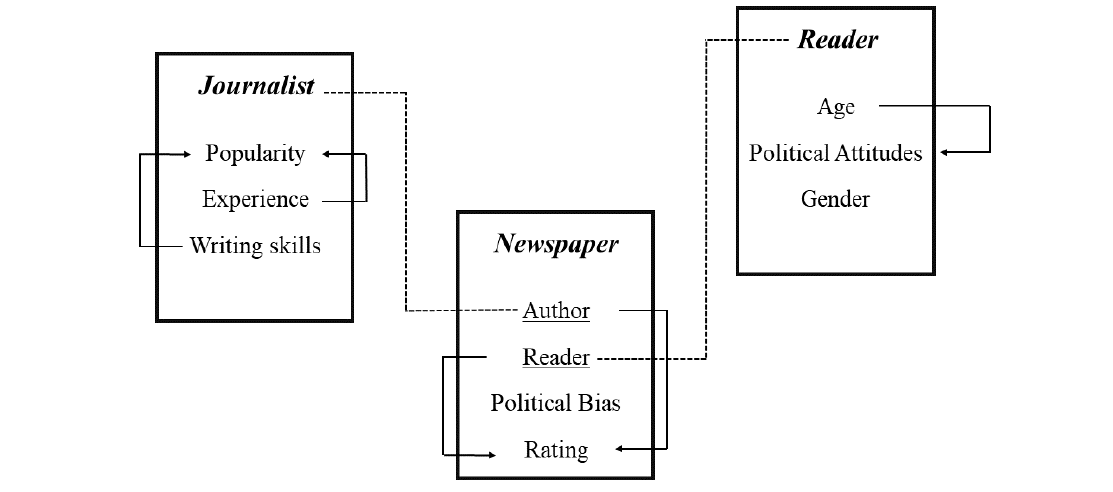
Figure 5. An example of a relational schema for a simple domain. The underlined attributes are reference slots of the class and the arrows show the types of objects to which they are